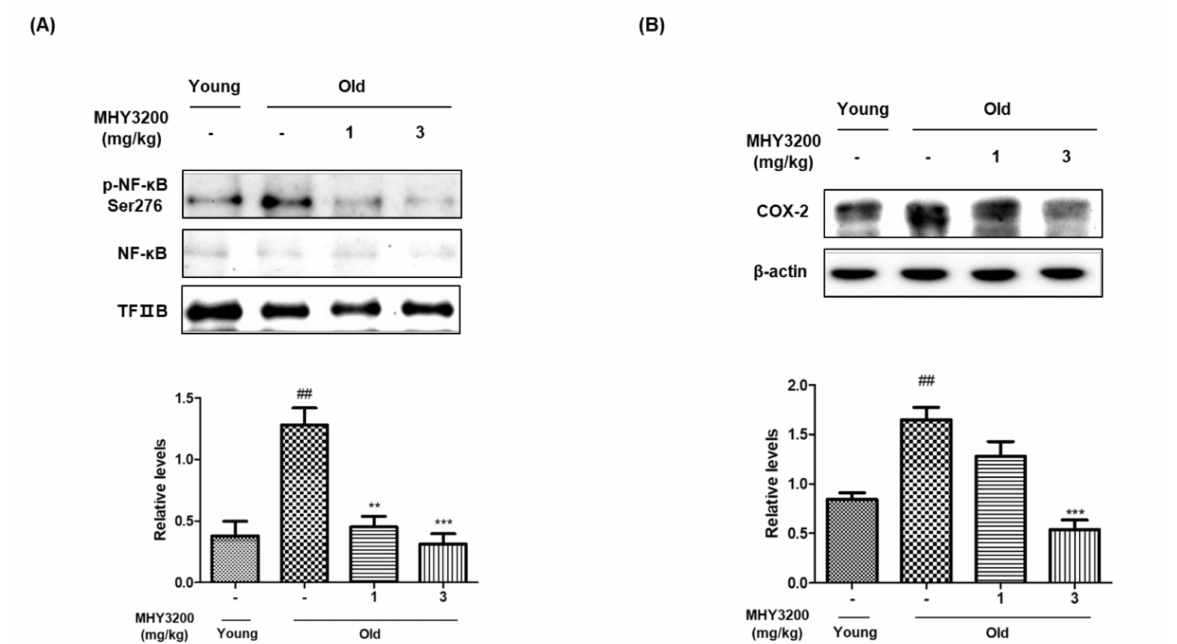
Figure 3. Effect of MHY3200 on NF- κ B and its downstream inflammatory signaling during aging. ( A ) Nuclear fraction NF- κ B and ( B ) cytosol fraction COX-2 protein levels were determined using Western blot analysis. TFIIB and β -actin were used as the nuclear and cytosolic internal controls and graphs were quantified with CS analyzer image analysis software. One representative blot is shown from three independent experiments in each group that yielded similar results ( n = 6). One-way analysis of variance (ANOVA) was used to determine the statistical result: ## p < 0.01 vs. Young rats; ** p < 0.01, *** p < 0.001 vs. Old rats. Young (-), non-treated young rats; Old (-), non-treated old rats; 1, MHY3200 (1mg/kg)-treated old rats; 3, MHY3200 (3mg/kg)-treated old